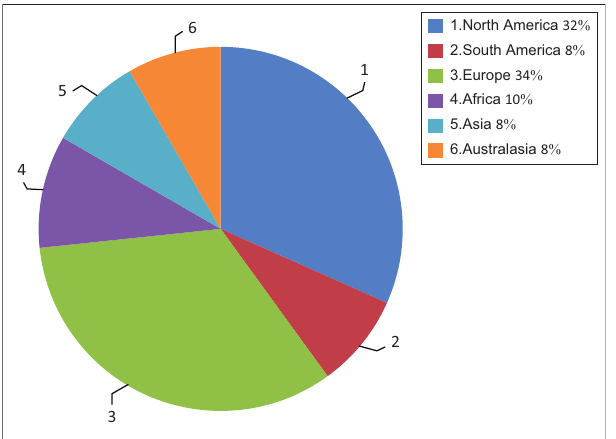
FIGURE 1: Geographic occurrence of reported supply chain